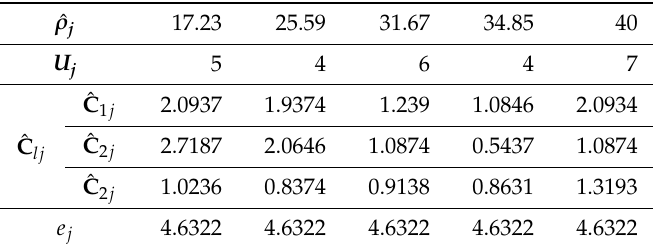
Table 3. Validation results.